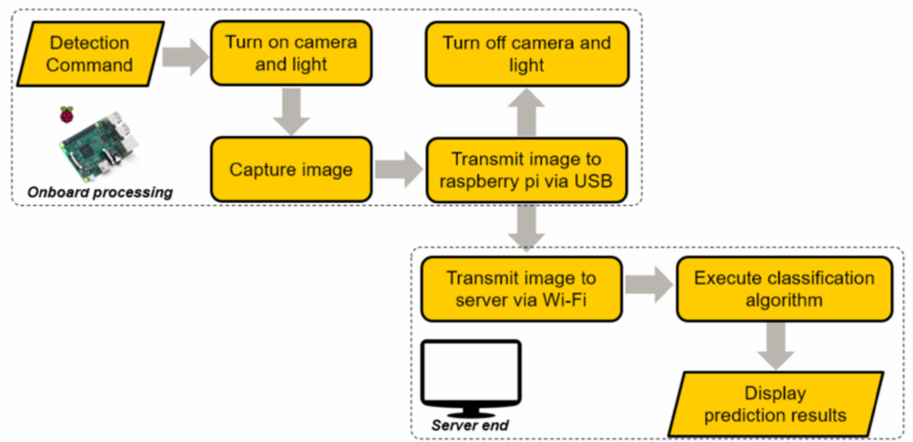
Figure 3. Process flow of the implemented detection